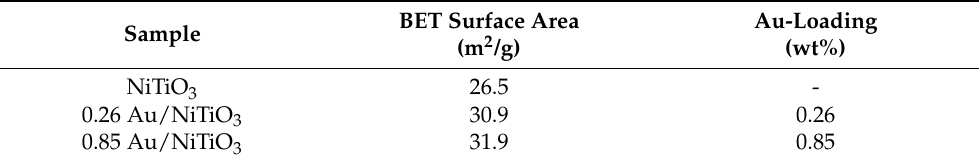
Table 1. BET surfaces areas of the NiTiO 3 and Au/NiTiO 3 samples and Au-loadings measured by ICP analysis.